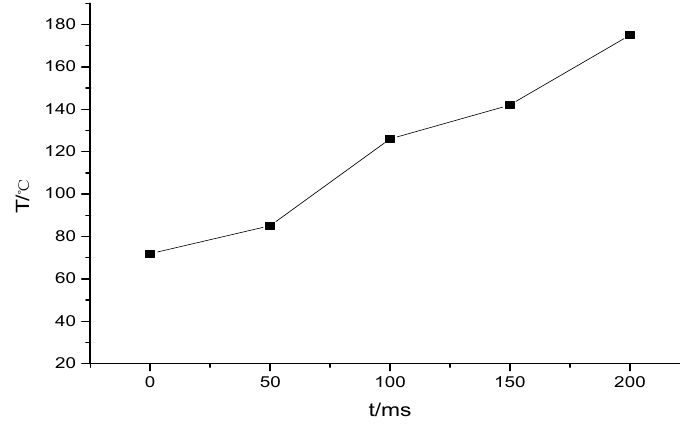
Figure 17. Variation of varistor temperature with impact time under the five pulse